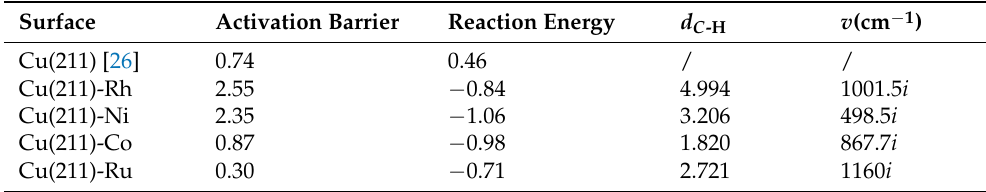
Table 5. The activation barrier(eV) and reaction energy (eV) of carbon dioxide hydrogenation via HCOO intermediate on the pure and transition-metal-doped Cu(211)-M (M = Rh, Ni, Co, and Ru) surfaces together with the C–H bond length ( d C-H /Å) in the transition state and the corresponding imaginary frequency of the transition state v (cm − 1